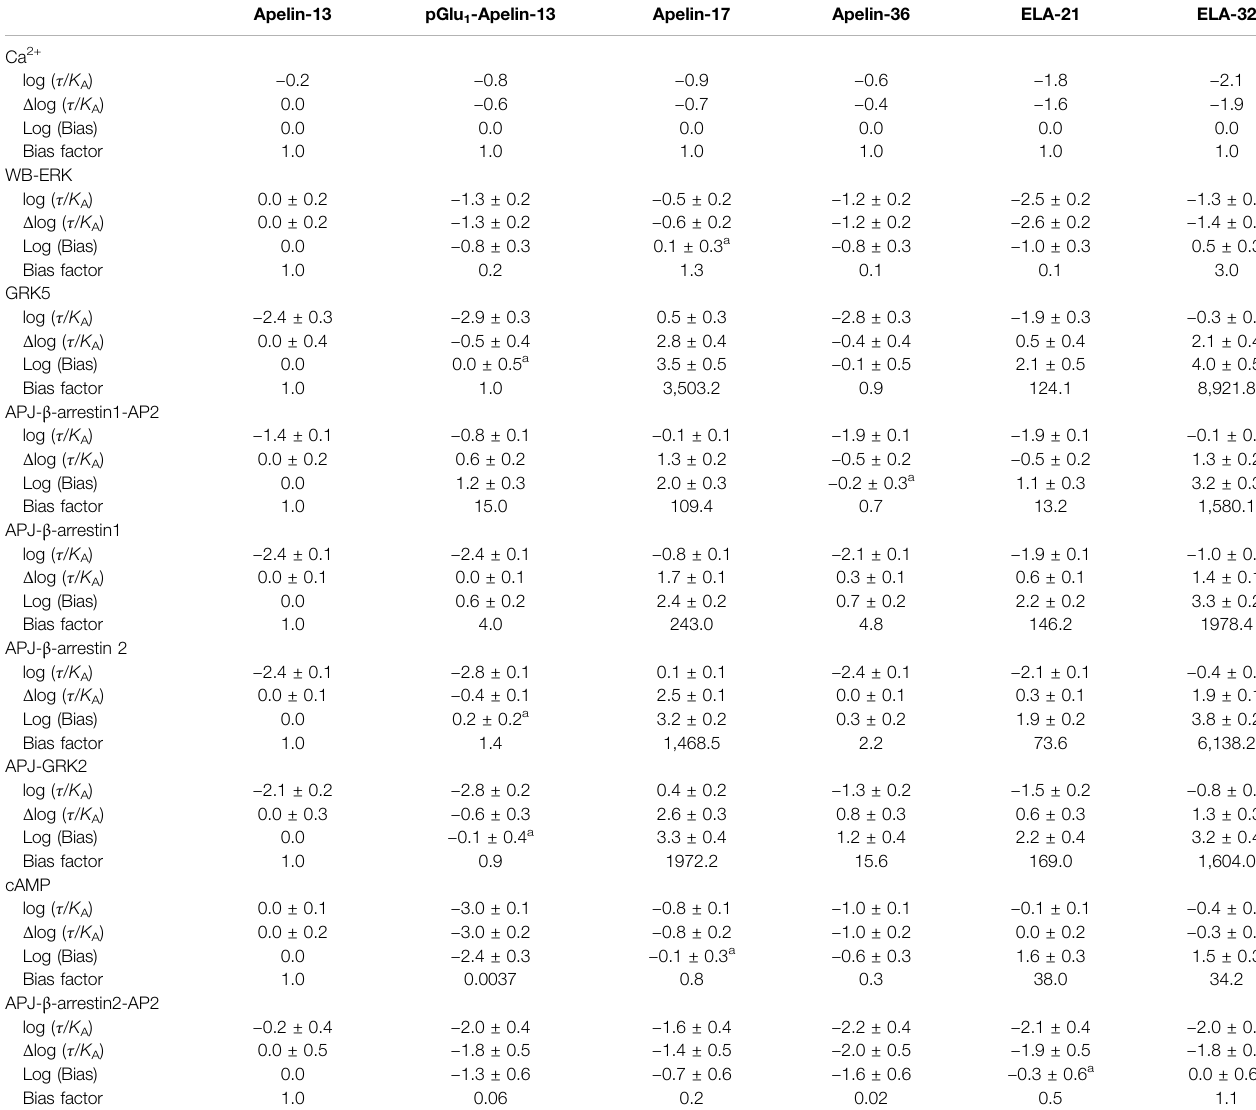
TABLE 3 | Bias factor and 95% con fi dence interval of the peptide